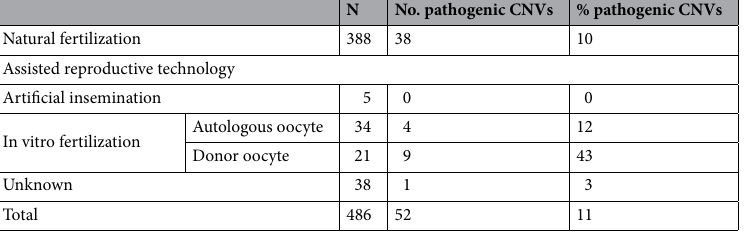
Table1. Summary of pathogenic CNVs found in patients according to the type of